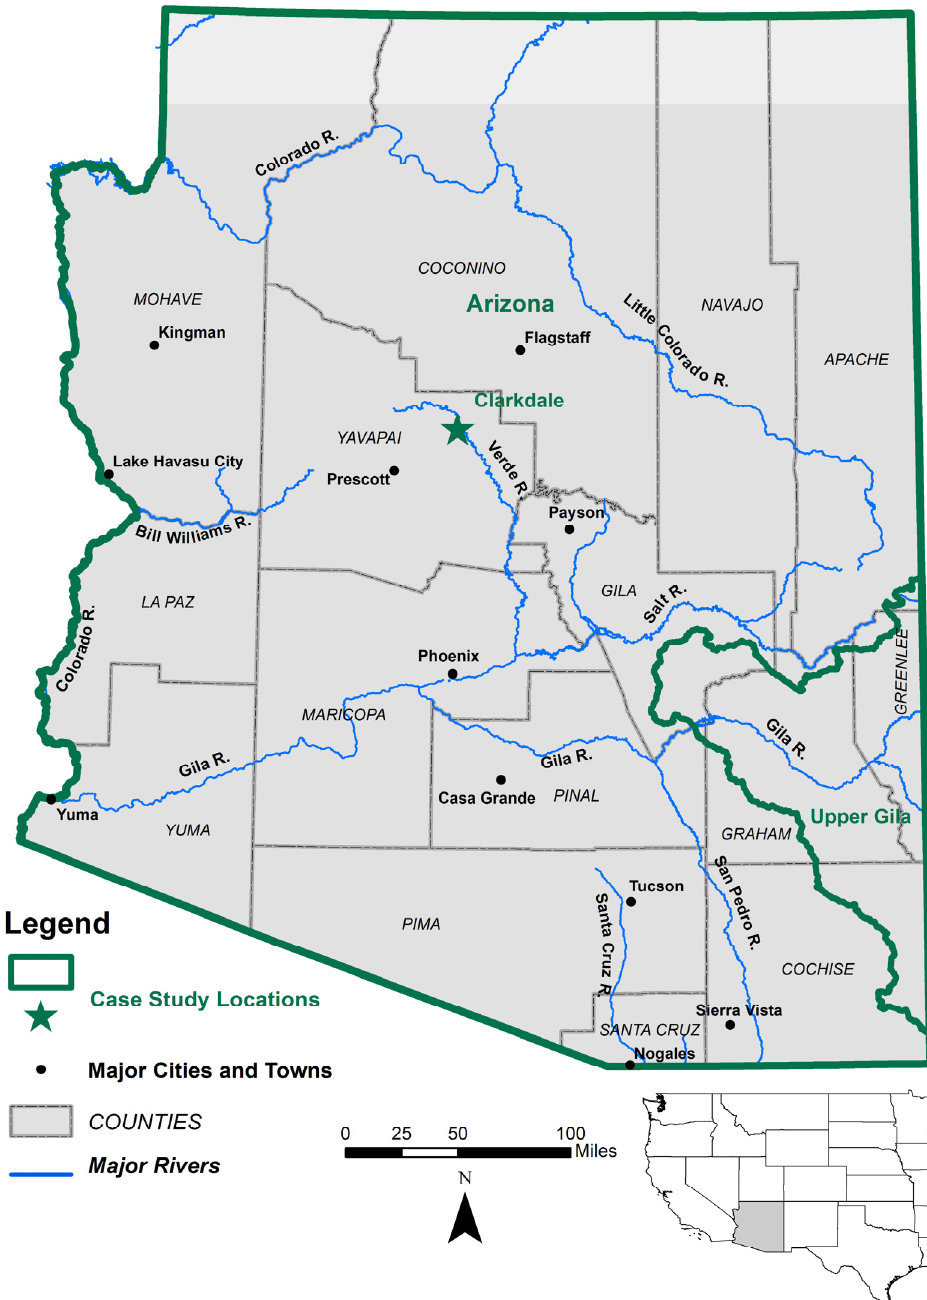
Figure 1. Geographic context and project locations (shown in green ). Engagement efforts examined in this paper occurred at the statewide level (Roadmap for Connecting the Environment to Arizona Water Planning (Roadmap), watershed level (Participatory Assessment for the Upper Gila Watershed (Gila)) and town level (Water Resources Management Program for the Town of Clarkdale (Clarkdale)).